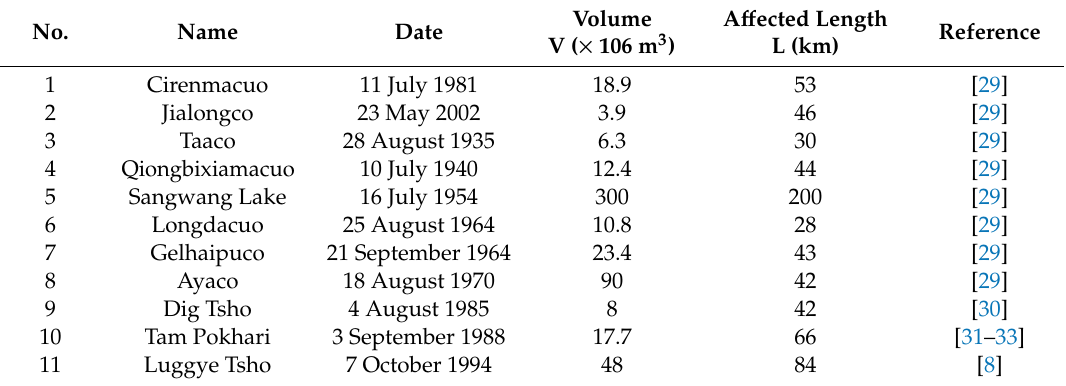
Table 1. Volume and a ff ected length of historical glacial lake outburst floods (GLOFs) that occurred in Nepal and Tibet